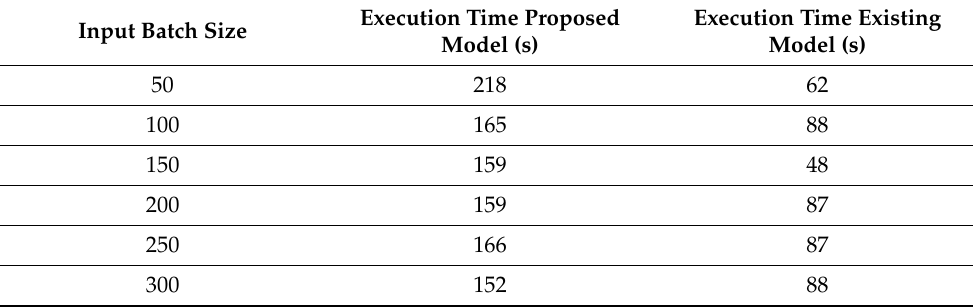
Table 7. Computational Complexity